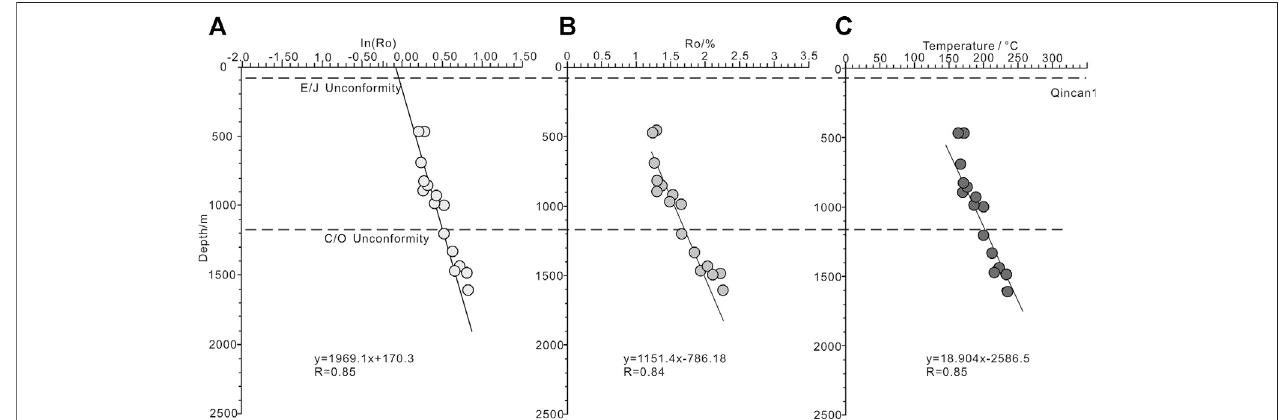
FIGURE 7 | Vitrinite re fl ectance ( R o ) and depth map. (A) The relationship between ln ( R o ) and depth of Qincan 1. (B) The relationship between Ro and depth of Qincan 1. (C) Maximum palegeotemperature of Qincan 1 well in central basin reverted by Ro.